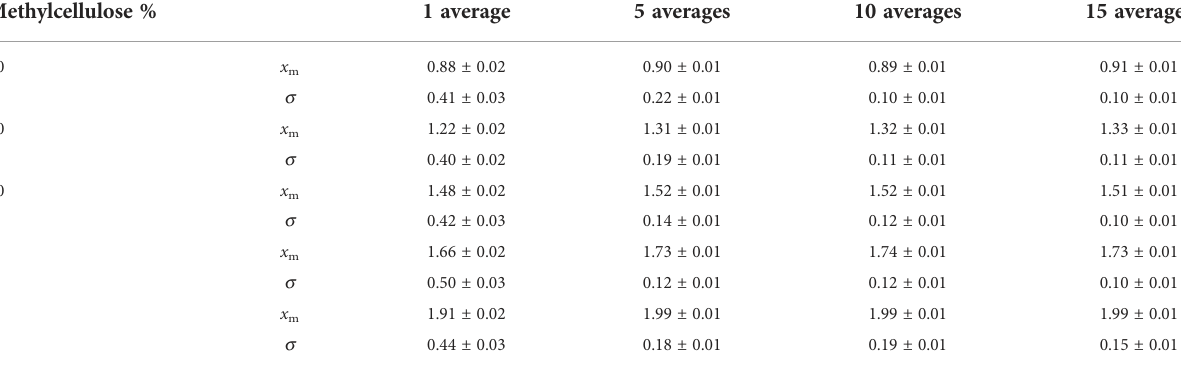
TABLE 4 Parameters of Gaussian fi ts for ADC value distributions for all methylcellulose concentrations and all averages analyzed. Methylcellulose %